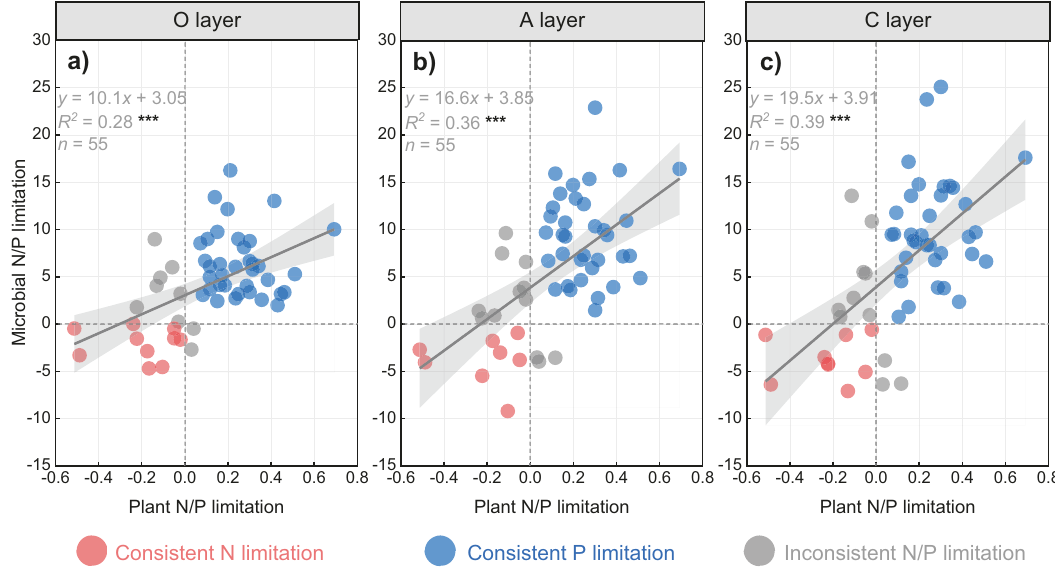
Fig. 4 Relationships between microbial N/P and plant N/P limitations in different soil layers across Chinese forests. a O-layer, soil organic horizon; b A layer, soil eluvial horizon; c C layer, soil parent material horizon. Solid line indicates model fi t between microbial N/P limitation and plant N/P limitation ( n = 55), while gray areas are the 95% con fi dence intervals of the model. *** represents signi fi cant relationships at P <